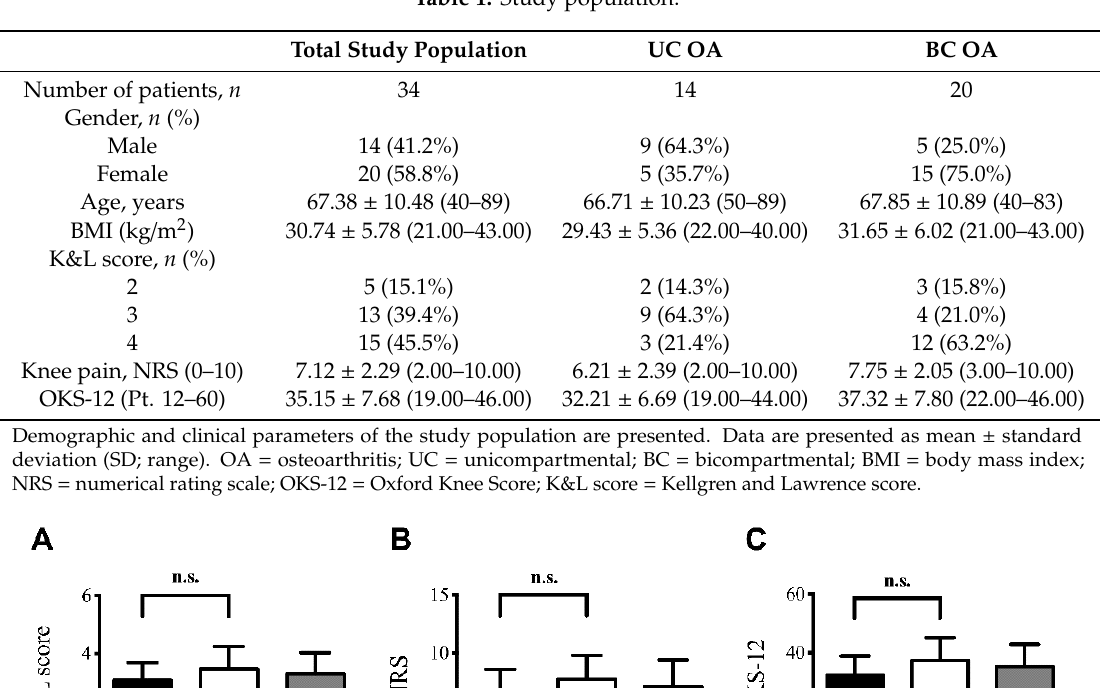
Table 1. Study population.